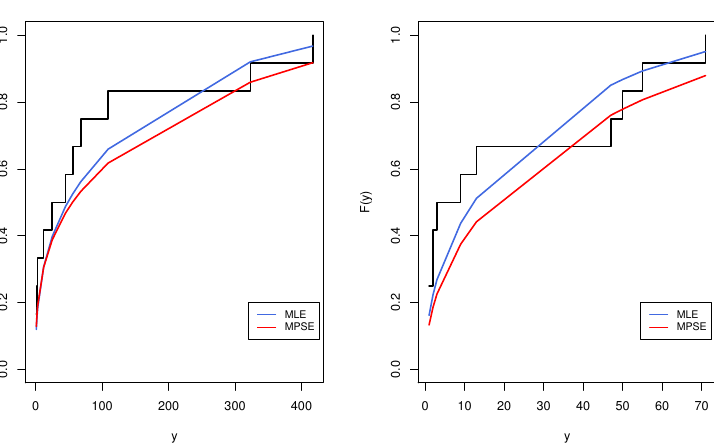
Figure 12. The empirical and fitted CDF of the MKE distribution for the breakdown of steel data.